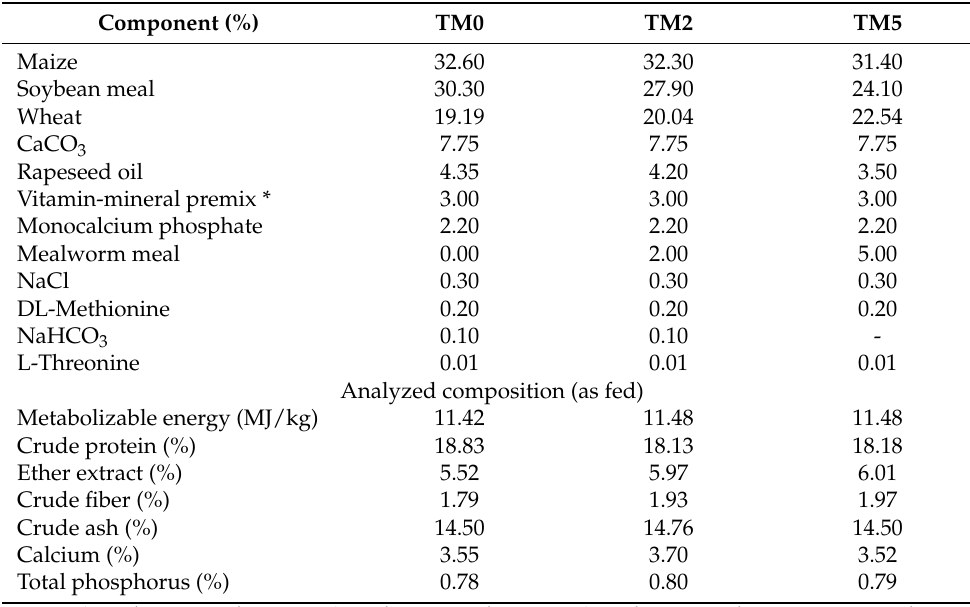
Table 1. Composition and nutrient content of the experimental